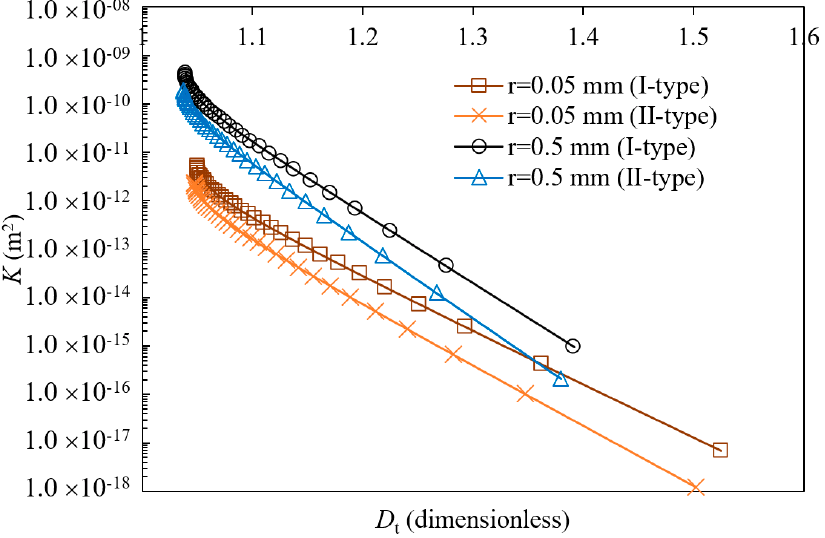
Figure 8. E ff ect of tortuosity fractal dimension on permeability of porous Figure 8. Effect of tortuosity fractal dimension on permeability of porous media.